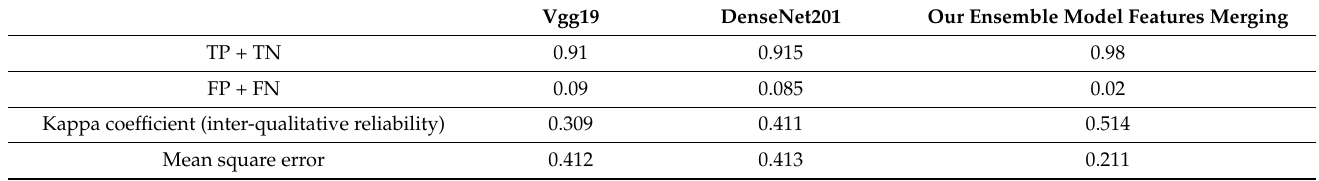
Table 5. Statistics metrics for the compared models for the Facemg